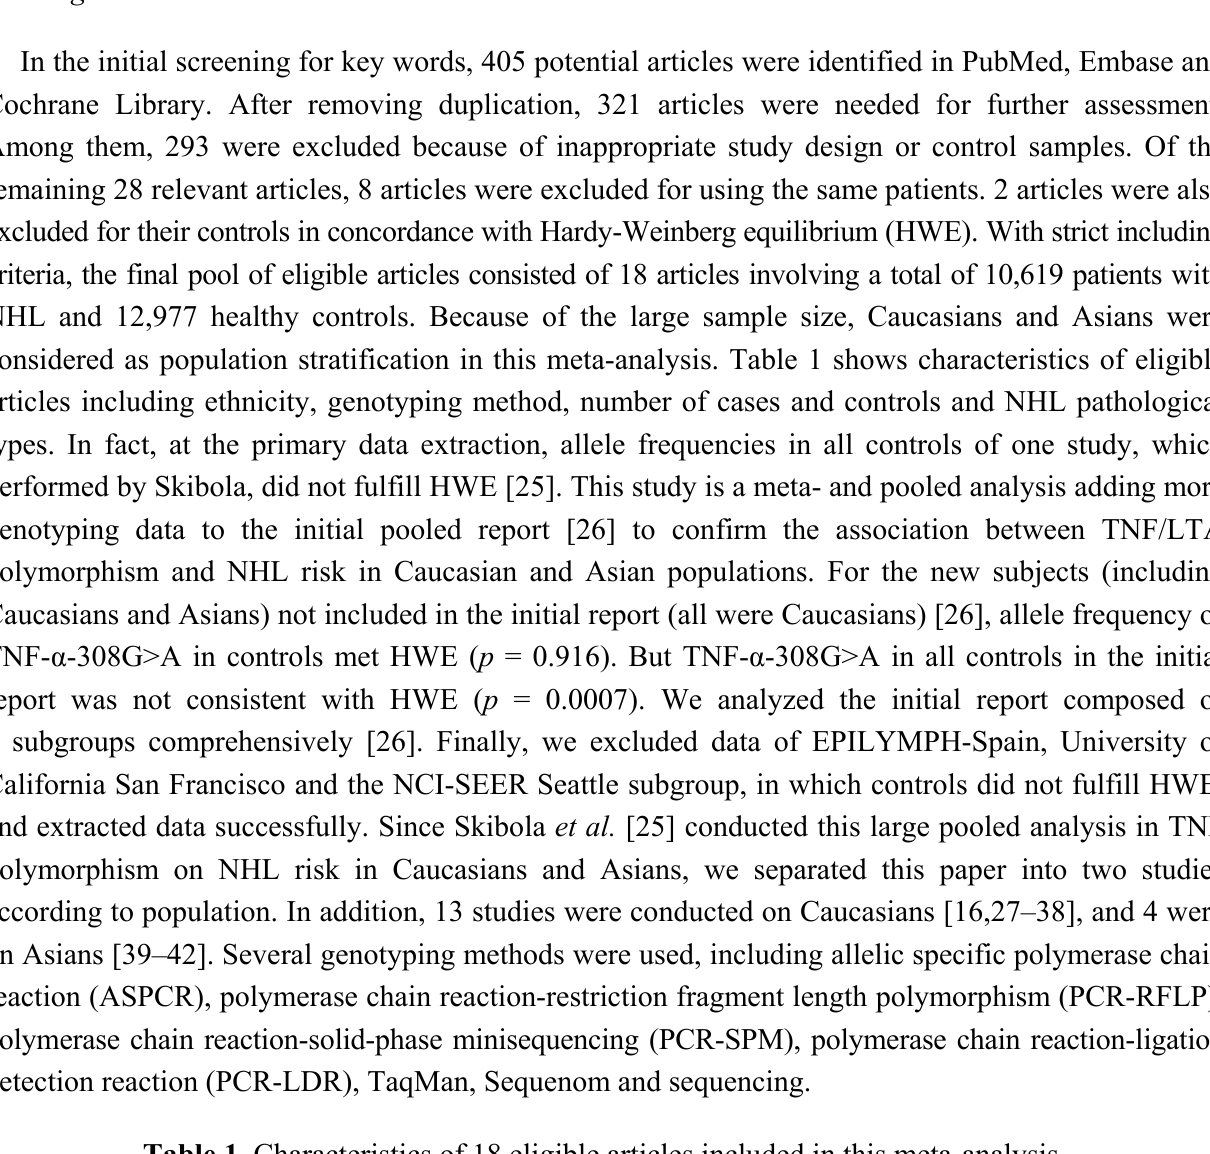
Table 1. Characteristics of 18 eligible articles included in this